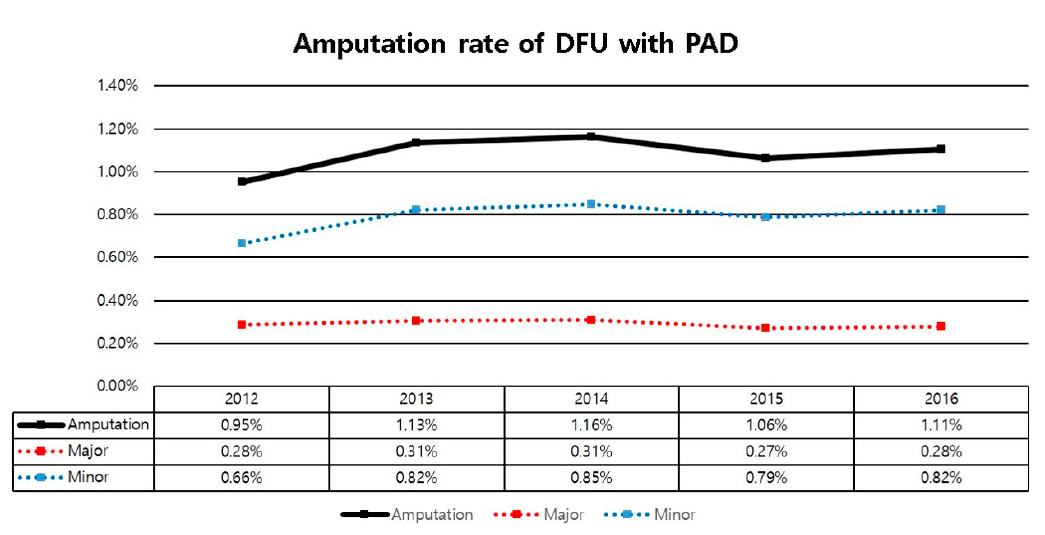
Figure 2. Annual amputation rate of diabetic foot ulcer with PAD.